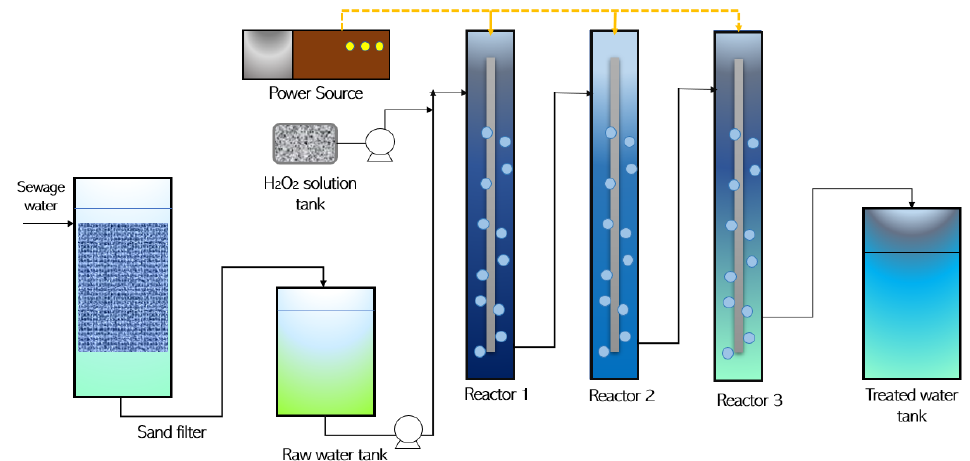
Figure 5. Scheme of a photocatalytic reactor.